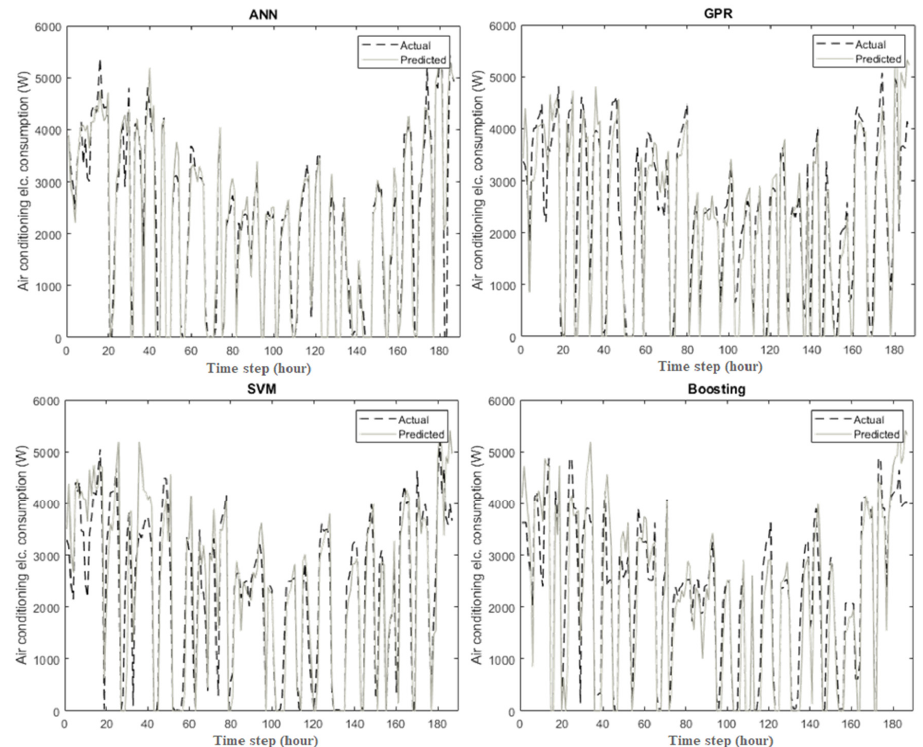
Figure 6. Measured and predicted air conditioning electrical consumption for the month of March (validation set).